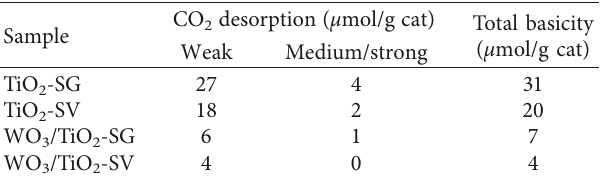
Figure 6: CO 2 -TPD profile of TiO 2 supports and WO 3 /TiO 2 catalysts. Table 4: The amount of surface basicity of supports and catalysts measured by CO 2 -TPD.